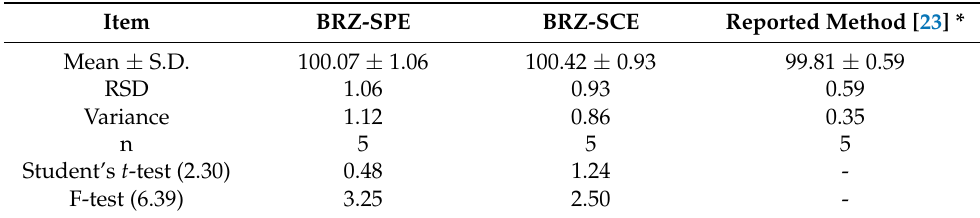
Table 5. Statistical comparison for the determination of bromazepam in bulk powder using the fabricated sensors with a reported